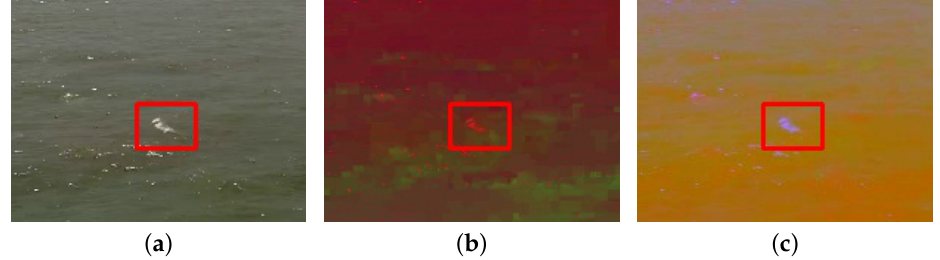
Figure 5. ( a ) Image containing sun glints and whitecap in RGB color space; ( b ) image containing sun glints and whitecap in HSV color space; and ( c ) image containing sun glints and whitecap in LAB color space (the display colors of this image have been modified to enhance the difference).